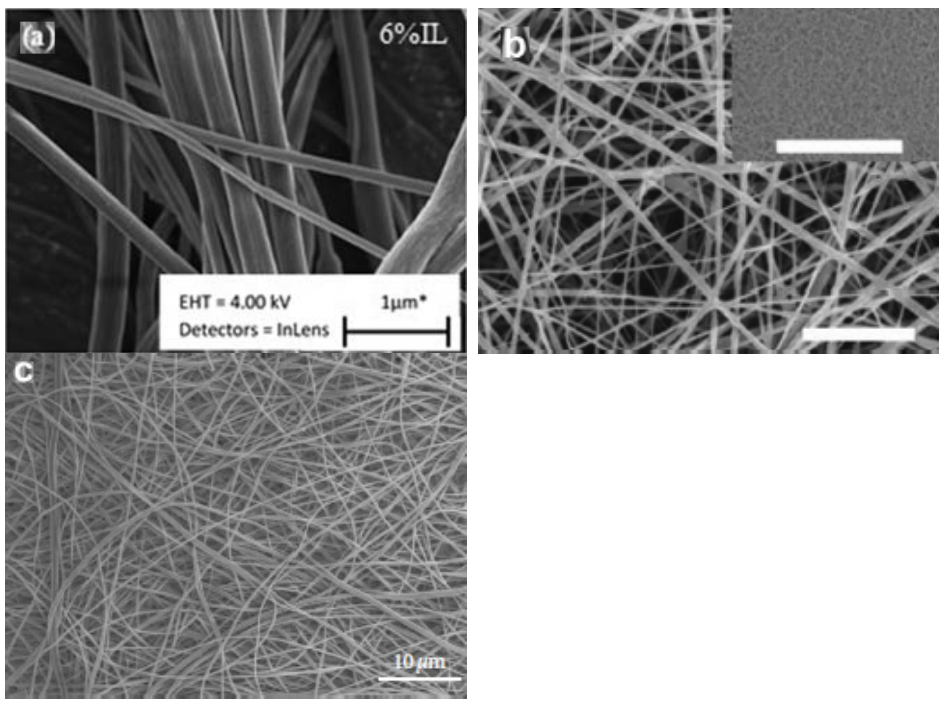
Figure 8. XRD patterns of ( a ) electrospun cellulose acetate fibers ( top ) [25]; and ( b ) electrospun PLA fibers ( top ) [39] assisted by different ionic liquids as additives.